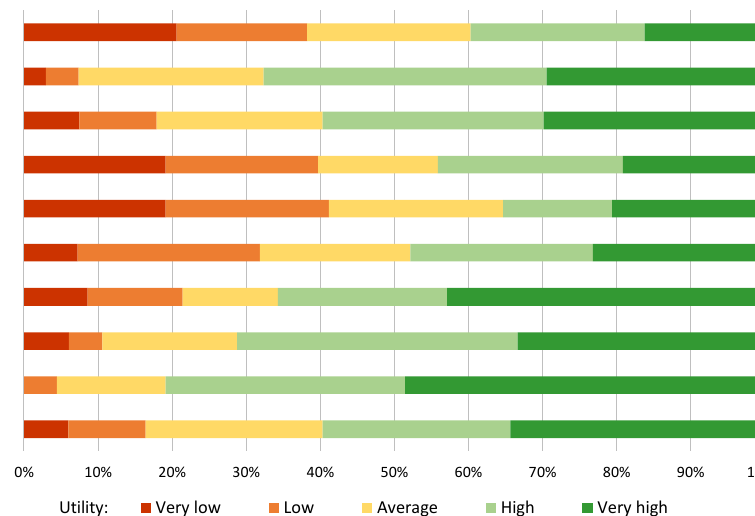
Figure 2. Results of the technology survey about forest fires in Spain.